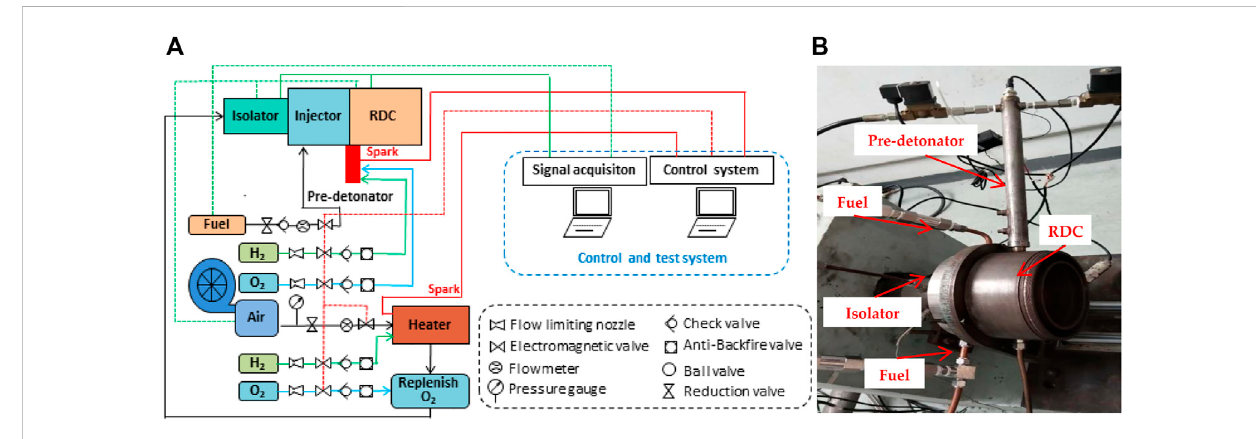
FIGURE 1 Diagram of the experiment system. (A) Schematic representation of the experiment system. (B) Photograph of the RDC test